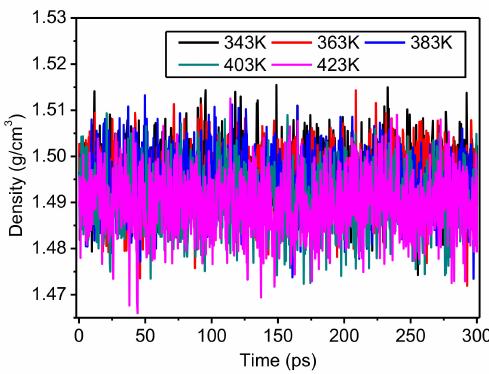
Figure 6. Change of the density in the crystalline regions of meta-aramid fibers during the simulations at different